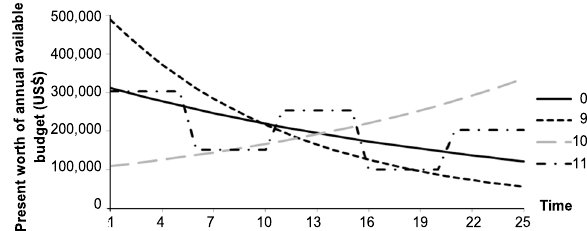
Fig. 6. Scenarios 9 to 11 have a similar total amount of funds but differ in their distribution over time